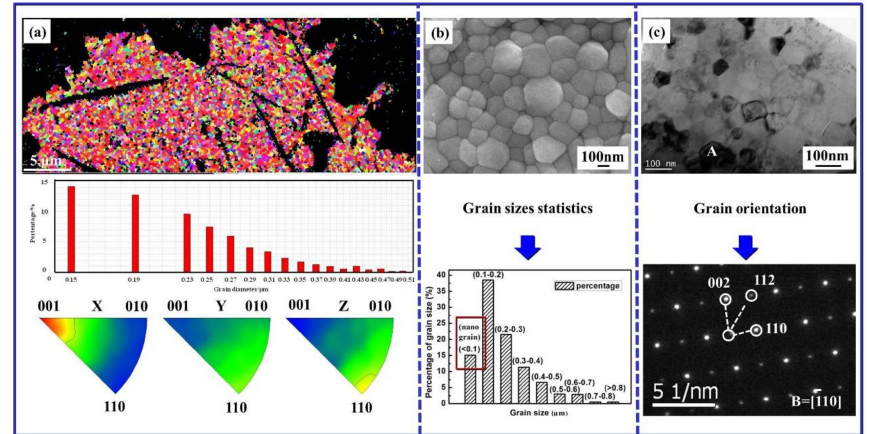
Figure 5. ( a ) Inverse pole figure (IPF), grain sizes distribution and IPF orientation maps of single-layered splat surface vertical to the substrate (normal direction); ( b ) Morphology of equiaxed grains and grain sizes statistics within coating after thermal etching at 1250 ◦ C for 3 h; ( c ) TEM image of equiaxed grains and corresponding selected area electron di ff raction (SAED)